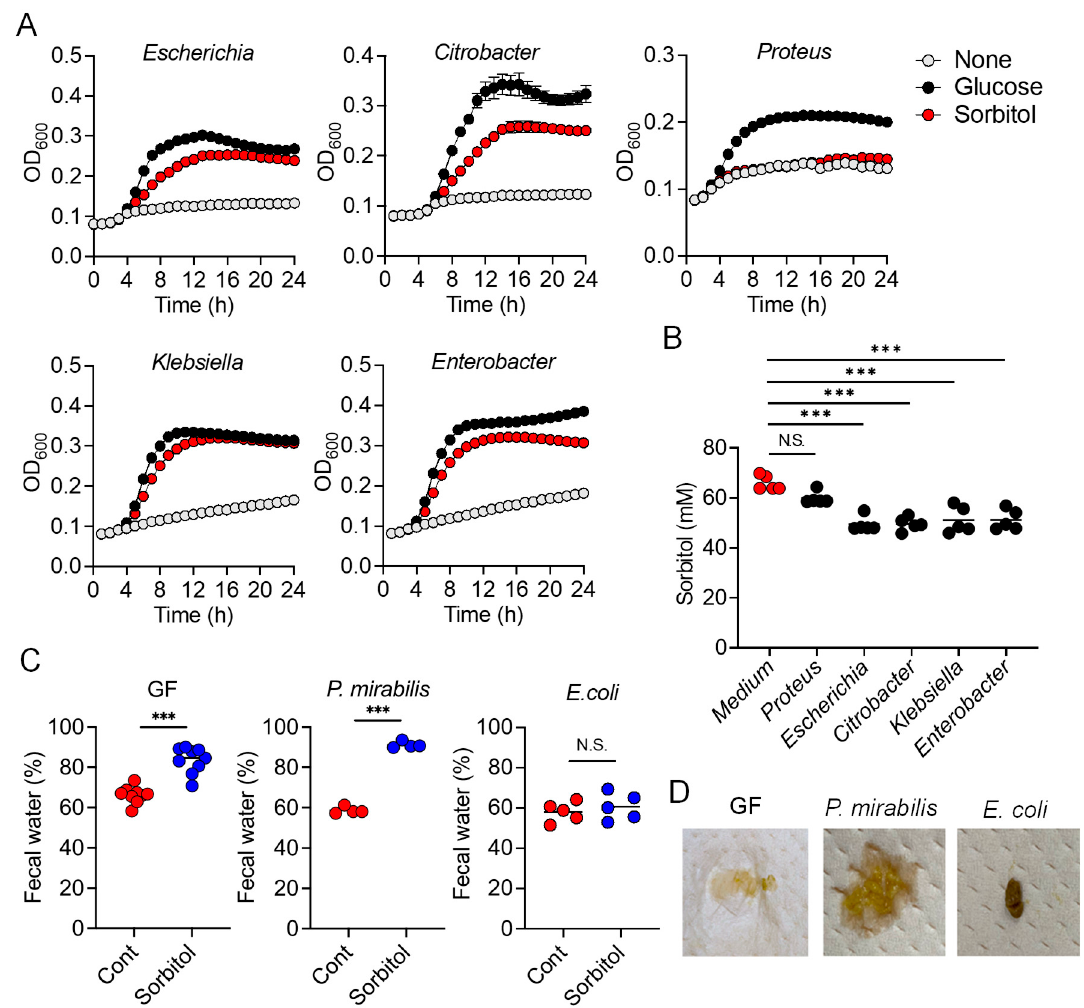
Figure 3. Escherichia coli are Able to Degrade Sorbitol and Suppress Sorbitol-Induced Diarrhea. ( A ) Each Enterobacteriaceae species was individually grown in M9 medium or M9 medium supplemented with 1% glucose or sorbitol and optical density (O.D.) at 600 nm was measured over time. ( B ) Sorbitol concentrations in 24 h culture supernatants of each Enterobacteriaceae ( n = 5). Bar charts are mean values. *** p < 0.001, compared with the control (Medium) group using Dunnett’s t -test. ( C , D ) IQI Germ-free (GF) mice or GF mice colonized with E. coli or P. mirabilis were provided drinking water containing 5% sorbitol for 4 days (GF mice, GF + E. coli mice; GF + P. mirabilis mice). ( C ) Fecal water content at day 0 and 4 after treatment with 5% sorbitol. Cont: control; 5%:5% sorbitol. Each dot represents an individual mouse and the horizontal bars indicate mean values. *** p < 0.001 by Welch’s t -test. ( D ) Image of representative feces from the gnotobiotic mice given 5% sorbitol for 4 days.